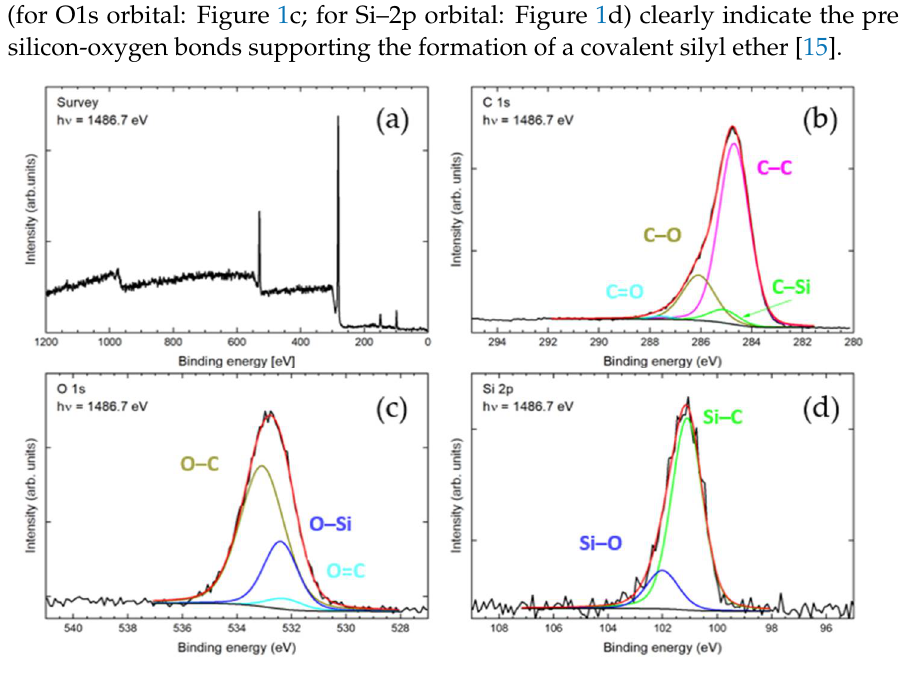
Figure 1. Results from XPS analysis: ( a ) Survey scan and selected regions attributed to ( b ) C1s, ( c ) O1s, and ( d ) Si2p orbital energies. Measured signals are displayed in black, fitted envelope curves in red. Results from deconvolutions are displayed within the individual energy regions and attributed to bonds, as illustrated by additional curves in various colors.